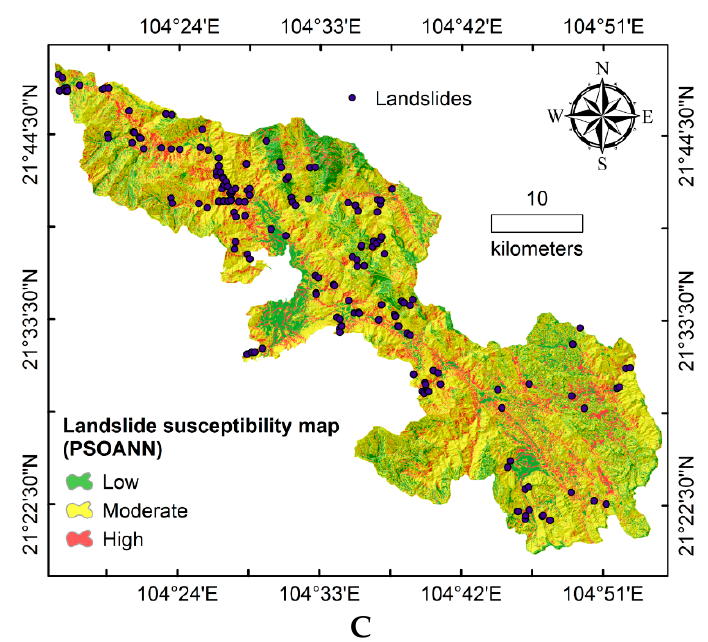
Figure 11. Landslide susceptibility maps of different models: ( A ) RFBFDT, ( B ) PSOANFIS, and ( C ) PSOANN.